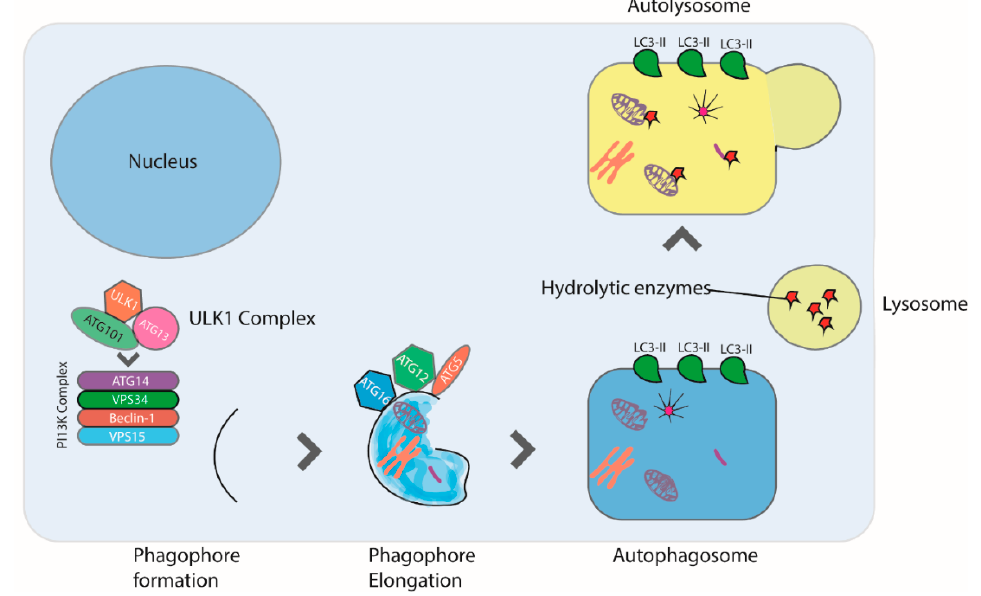
Figure 2. Autophagy is induced in response to starvation, reactive oxygen species, hypoxia, infection, and drugs. Autophagy begins with the formation of the phagophore, a step mediated by the ULK1 complex. Next, phagophore nucleation requires the PI3K complex, which consists of ATG14L, VPS34, Beclin-1, and VPS15 proteins. Autophagosome formation requires the lipidation of LC3 to form LC3II. Finally, the autophagosome fuses with a lysosome forming the autophagolysosome, leading to the degradation of the sequestered organelles and cytosolic proteins.